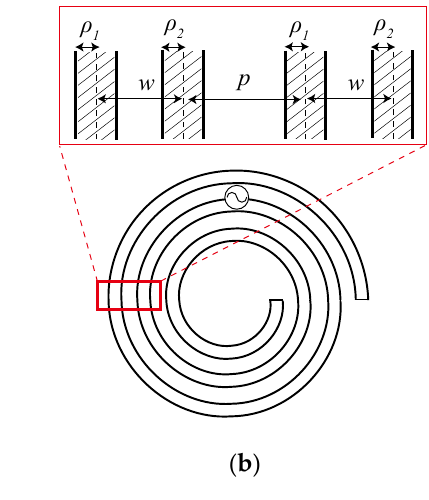
Figure 1. Folded-dipole structure.